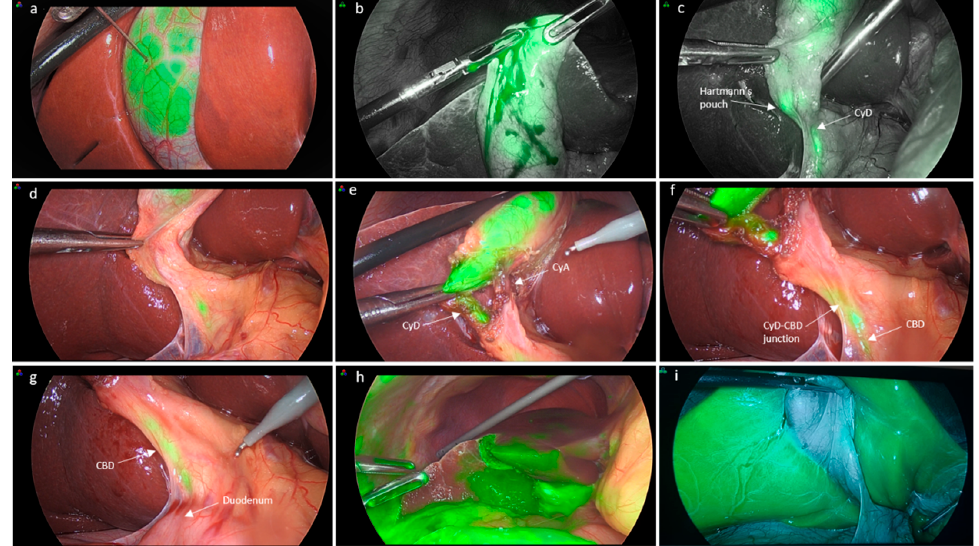
Figure 1. Intracholecystic ICG injection. ( a ) ICG injection by direct puncture of the gallbladder with a 27-gauge needle; ( b ) minimal spillage of ICG at the level of the puncture site, which is readily grasped to prevent further spillage; ( c ) milking of the gallbladder to allow for delineation of distal bile ducts; ( d ) ICG visualization prior to dissection and ( e , f ) after dissection of Calot’s triangle; ( g ) the common bile duct is clearly visualized also in its distal portion; ( h ) view of the abdominal cavity after a case of significant ICG spillage; and ( i ) erroneous administration of ICG in the gallbladder wall rather than in its lumen causing one case of hepatic fluorescence in the IC-ICG (CyD: cystic duct, CyA: cystic artery, CBD: common bile duct).